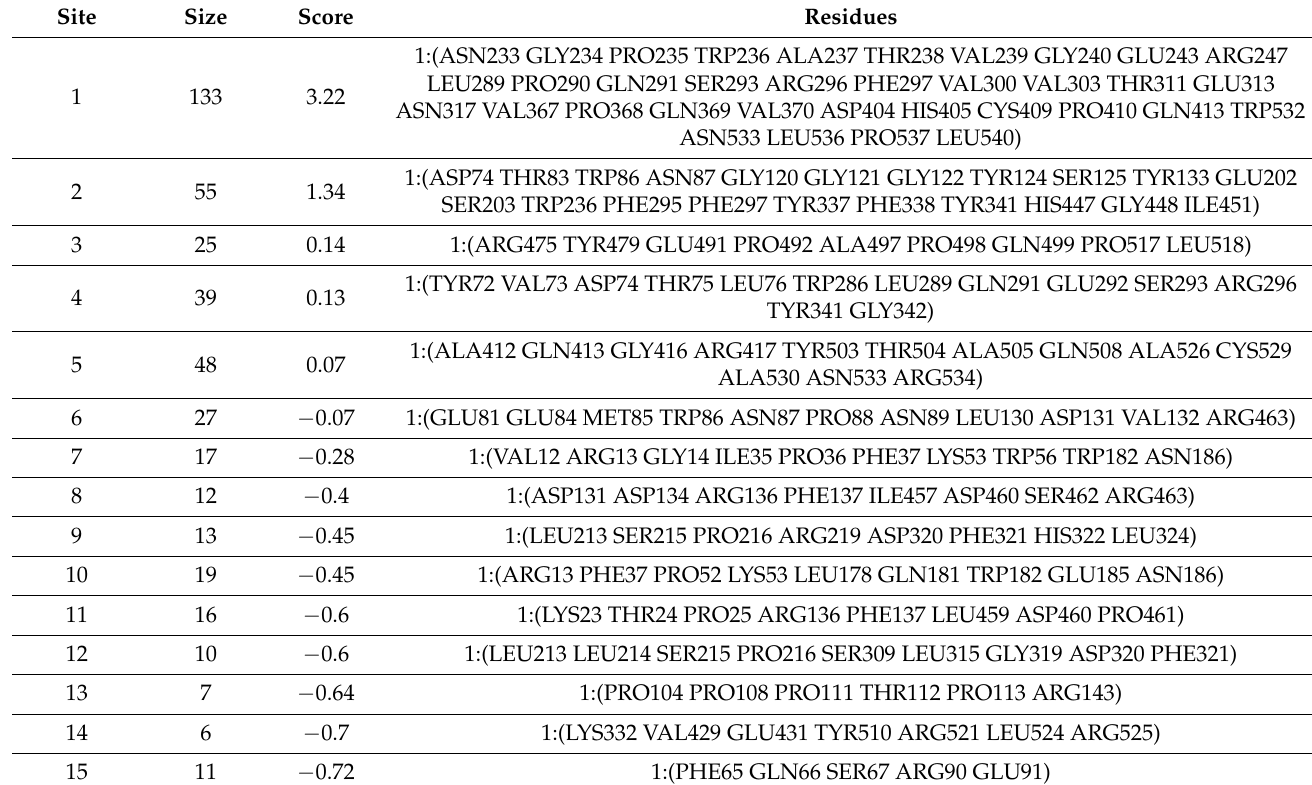
Table 6. Predicted binding sites for